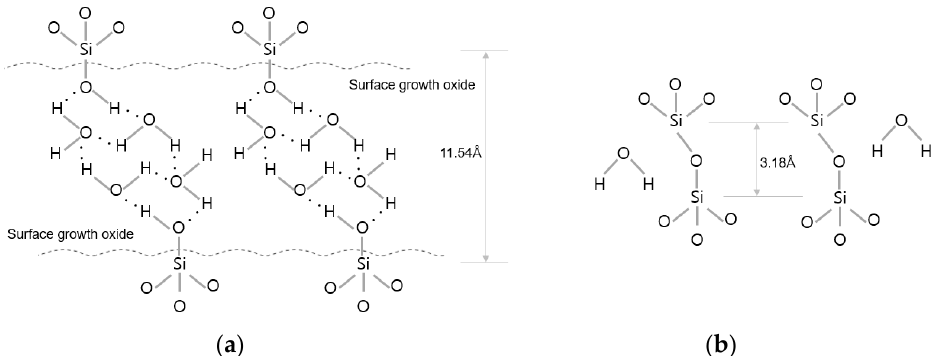
Figure 1. Description of binding mechanism during wafer bonding. ( a ) After the bonding process at room temperature. ( b ) After annealing process ( ≥ 150 °C).